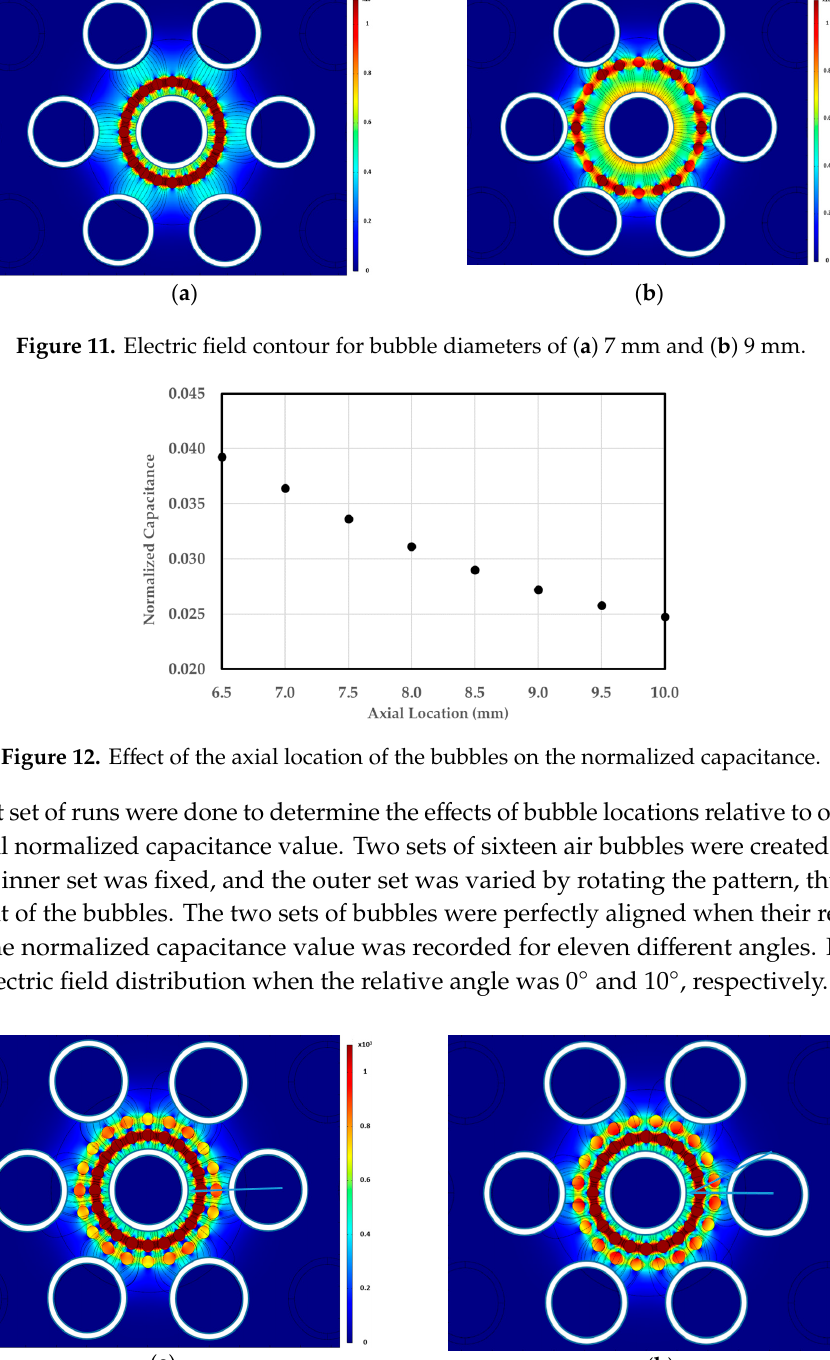
Figure 14. Effect of the relative angle between the two bubble sets on the normalized capacitance. 3.3. Effect of Bubble Distributions on Sensor Response. Three different uniform distributions were simulated to test the sensitivity of the sensor to the bubble distributions and orientation. The first test had circular bubbles that were generated using a rectangular array (Arrangement 1) shown in Figure 15a. In this configuration, each of the other circular patterns was rotated by five degrees to minimize the number of bubbles in each electric field line. The second test had circular bubbles that were generated using a rectangular array (Arrangement 2) shown in Figure 15b. In the third, elliptical bubbles with a 1:2 ratio were used. The bubbles were then rotated by 45 degrees. The elliptical bubbles were distributed using a circular array